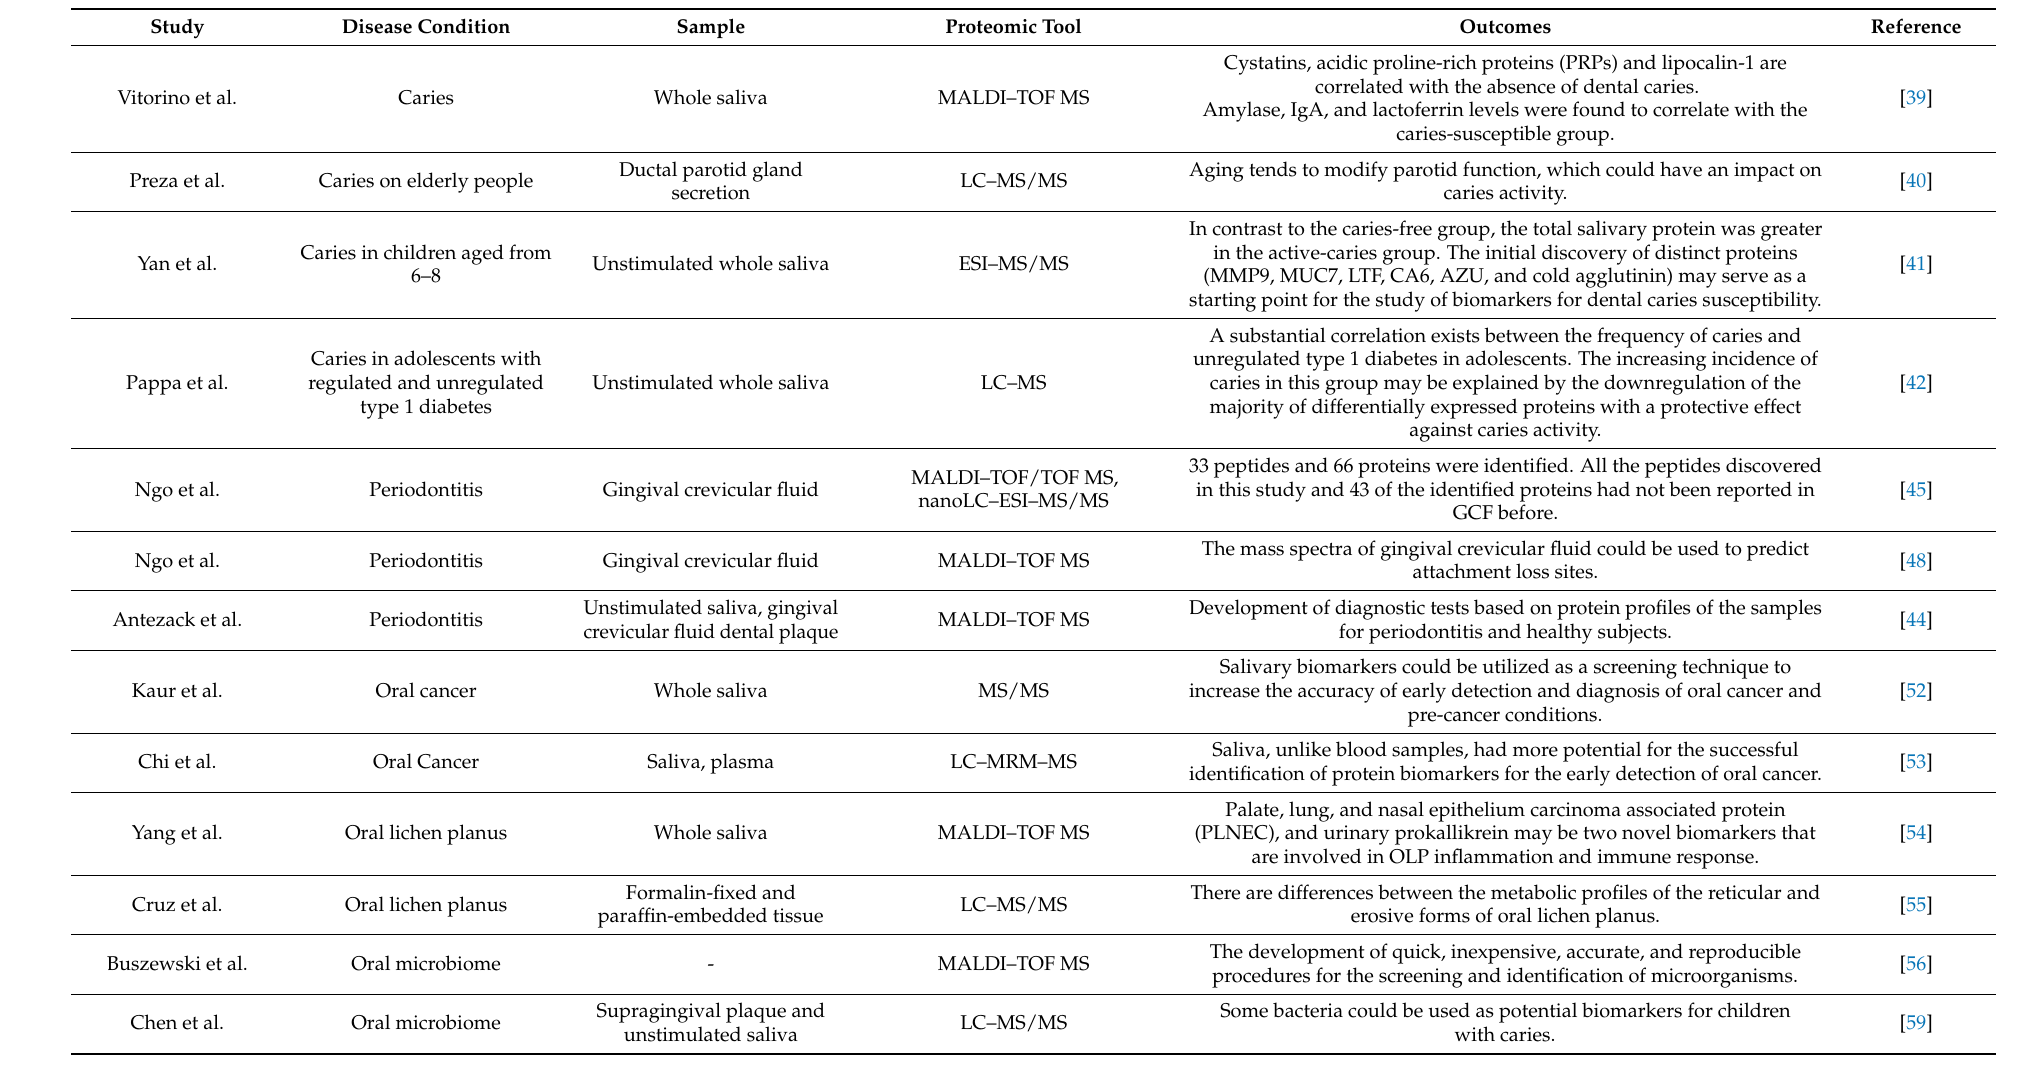
Table 2. Use of MS techniques for diagnostic